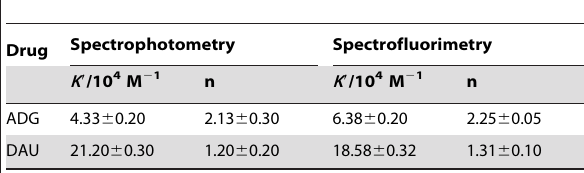
Table 1. Binding parameters of tRNA complexation with ADG and DAU obtained from spectrophotometric and spectrofluorimetric studies in CP buffer 20 mM [Na + ] at 20 u